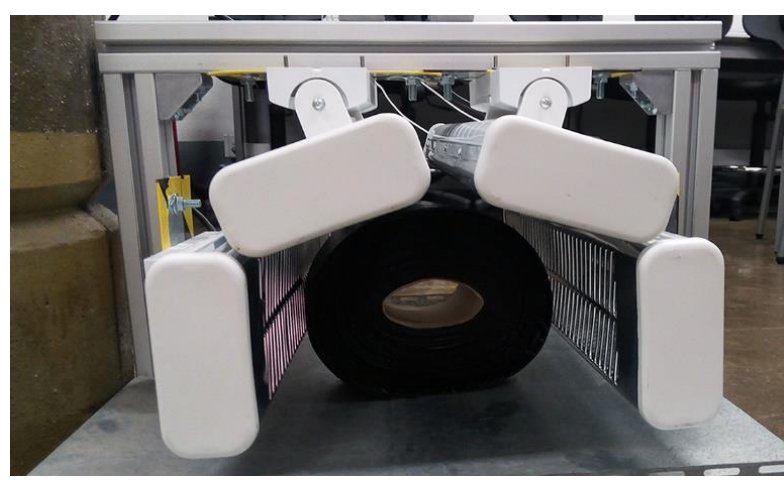
Figure 16 . Slice of asphalt roll surrounded by infrared heaters. Figure 16. Slice of asphalt roll surrounded by infrared heaters.